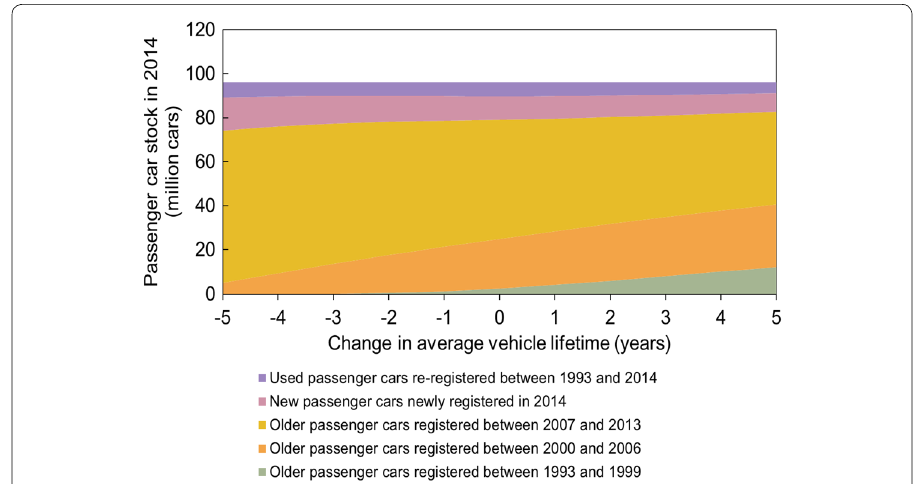
Fig. 3 Passenger car stock in 2014 under the lifetime change scenarios (benchmark: θ